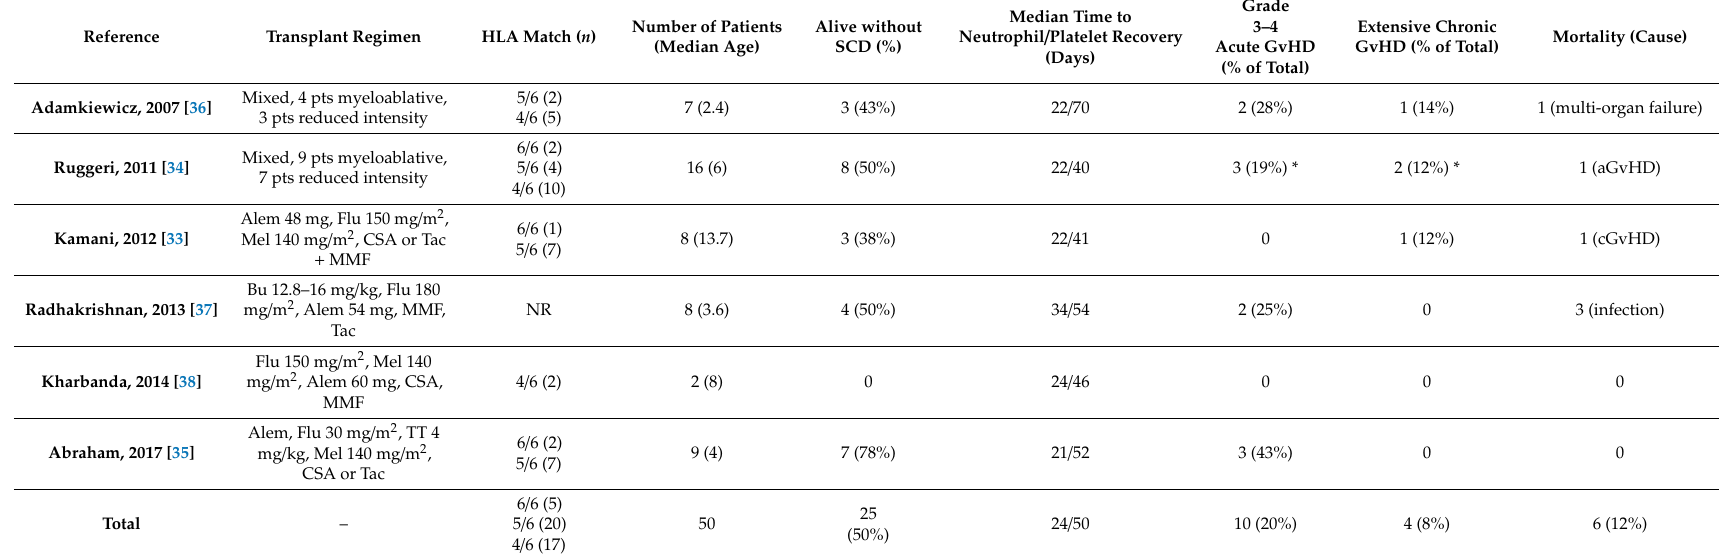
Table 2. Pediatric unrelated umbilical cord transplants for